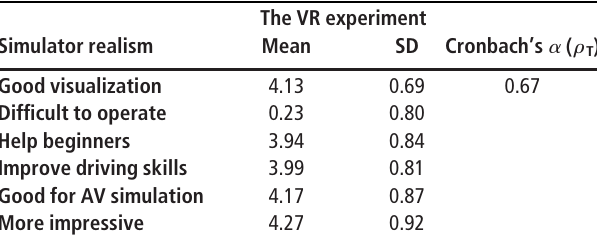
Table 6 Participants ’ feedback regarding simulator